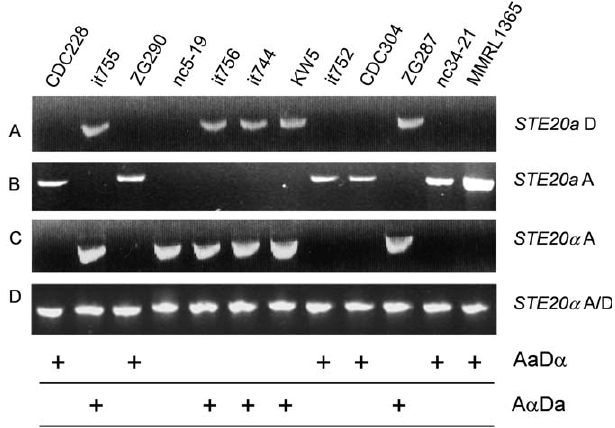
Figure 1. PCR Amplification of Portions of the STE20 Gene from the AD Hybrid Strains Using Mating Type– and Serotype-Specific Primers (A) PCR primers specific to MAT a serotype D allele ( STE20D a ); (B) PCR primers specific to MAT a serotype A allele ( STE20A a ); (C) PCR primers specific to MAT a serotype A allele (STE20A a ); (D) PCR primers specific to MAT a serotype A/D allele (STE20A/D a ) . Lanes 1–12 represent the following strains (from left to right): CDC228, it755, ZG290, nc5–19, it756, it744, KW5, it752, CDC304, ZG287, nc34–21, and